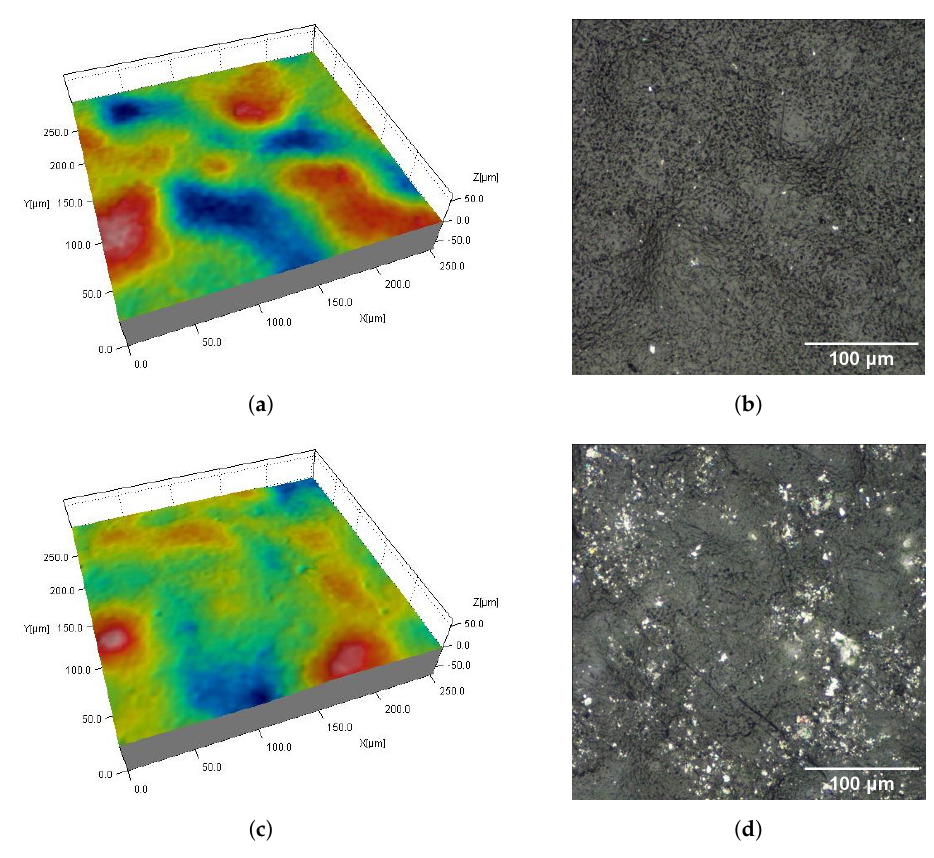
Figure 9. Surfaces of MJF samples after chemical smoothing DM_VFS_Col ( a , b ) and AMT_CVS ( c , d ): fragments 0.5 mm × 0.5 mm of 3D maps ( a , c ) and corresponding 2D views ( b , d